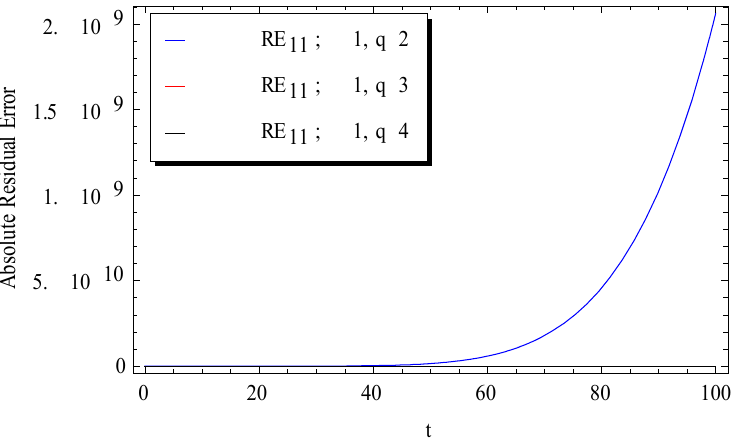
Figure 10. Effect of q on the absolute remainder error at 1 =λ .